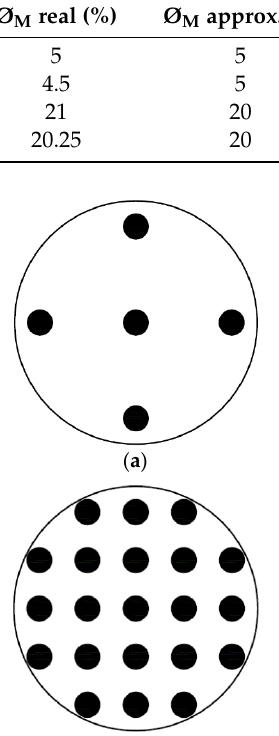
Table 1. Detailed parameters of the four drilling configurations measured